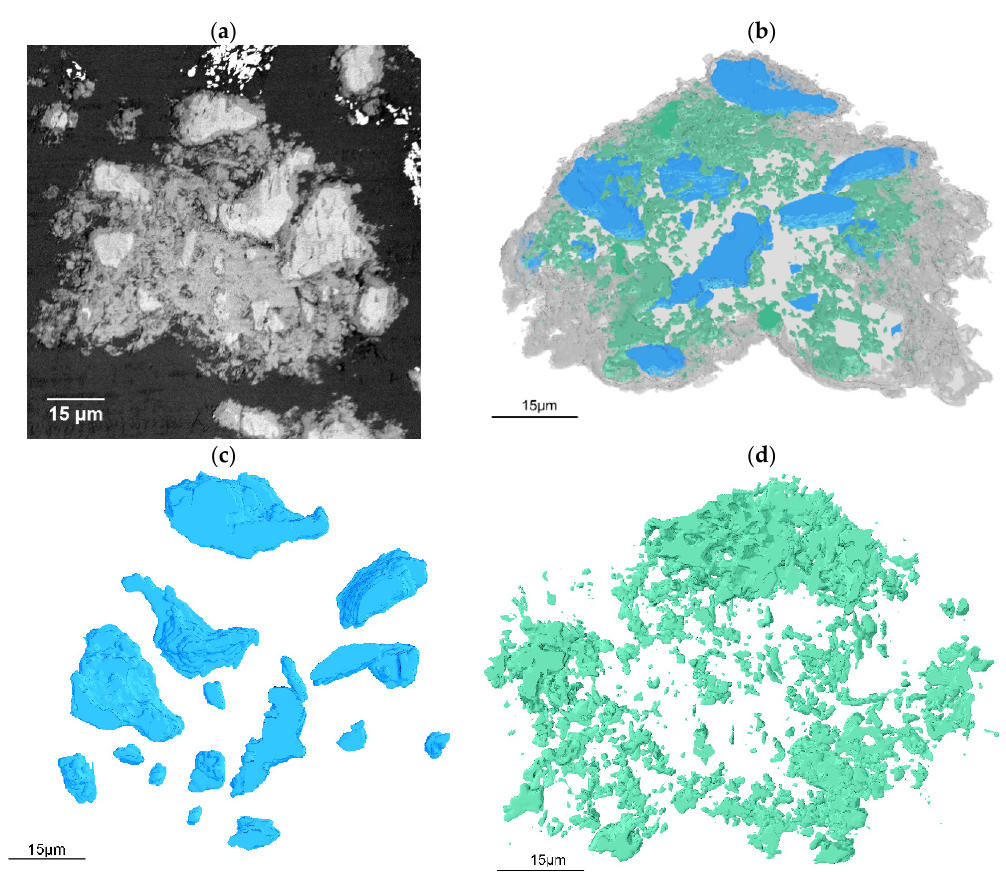
Figure 1. Two-dimensional and three-dimensional images of the hydrated C 3 S: ( a ) the original BSE image of samples, ( b ) the 3D rendered image of the sample, ( c ) anhydrous particles, and ( d ) pores in the hydrated C 3 S